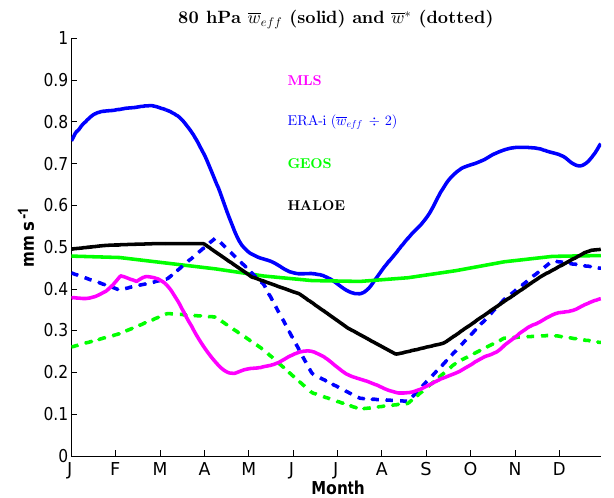
Figure 4. The effective vertical log–pressure transport velocities at 80hPa (solid; converted from pressure velocities using H = 7km) compared to the TEM vertical residual velocities (dashed) from ERA-i and GEOS CCM. The ERA-i effective velocity has been di- vided by 2 to fit within the shown axis